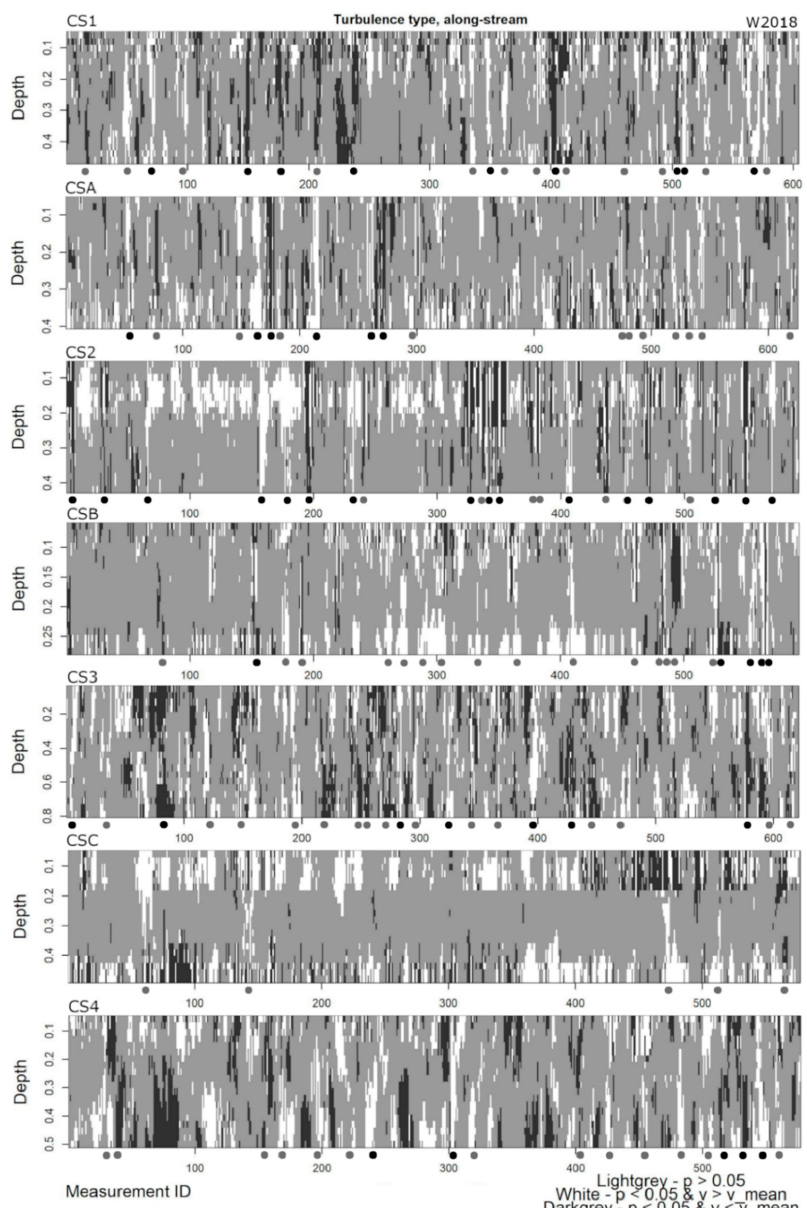
Figure 3. The LISA analysis results at each measurement location, calculated based on along-stream (i.e., streamwise) velocity of W2018. Measurement ID means the sample numbers ( n ), and therefore also represents seconds. The black dots indicate the occurrence times of statistically significant strong high and low flow wedges reaching from the surface to the riverbed. The grey dots indicate the times when there is weaker wedge (i.e., a cluster has broken with a few cells within the vertical water column).